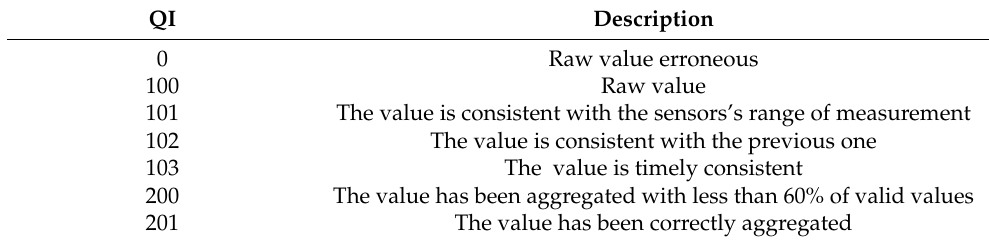
Table 2. Quality Indexes list.